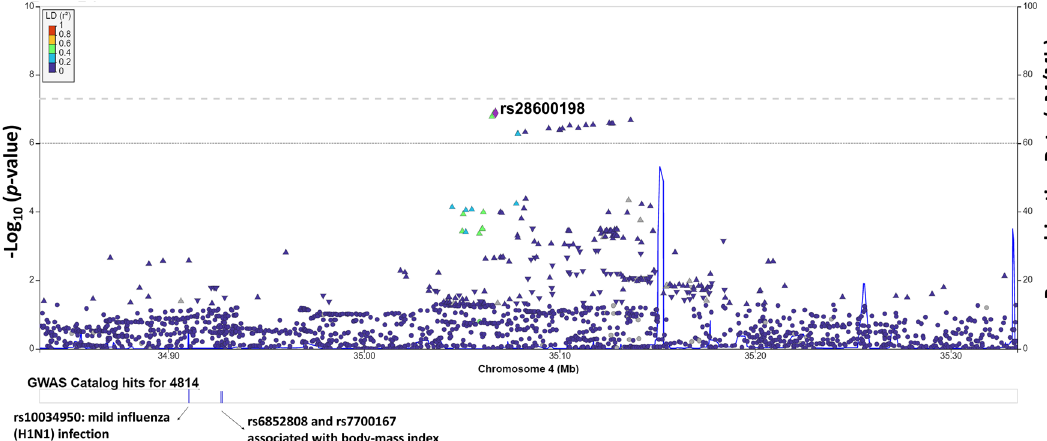
Figure 4. LocusZoom plot of the genomic region associated with tinnitus. The graph shows the linkage disequilibrium in the region of rs28600198. Each dot is showing the p -value for the SNPs in this region. The color bar indicates the level of the linkage disequilibrium.